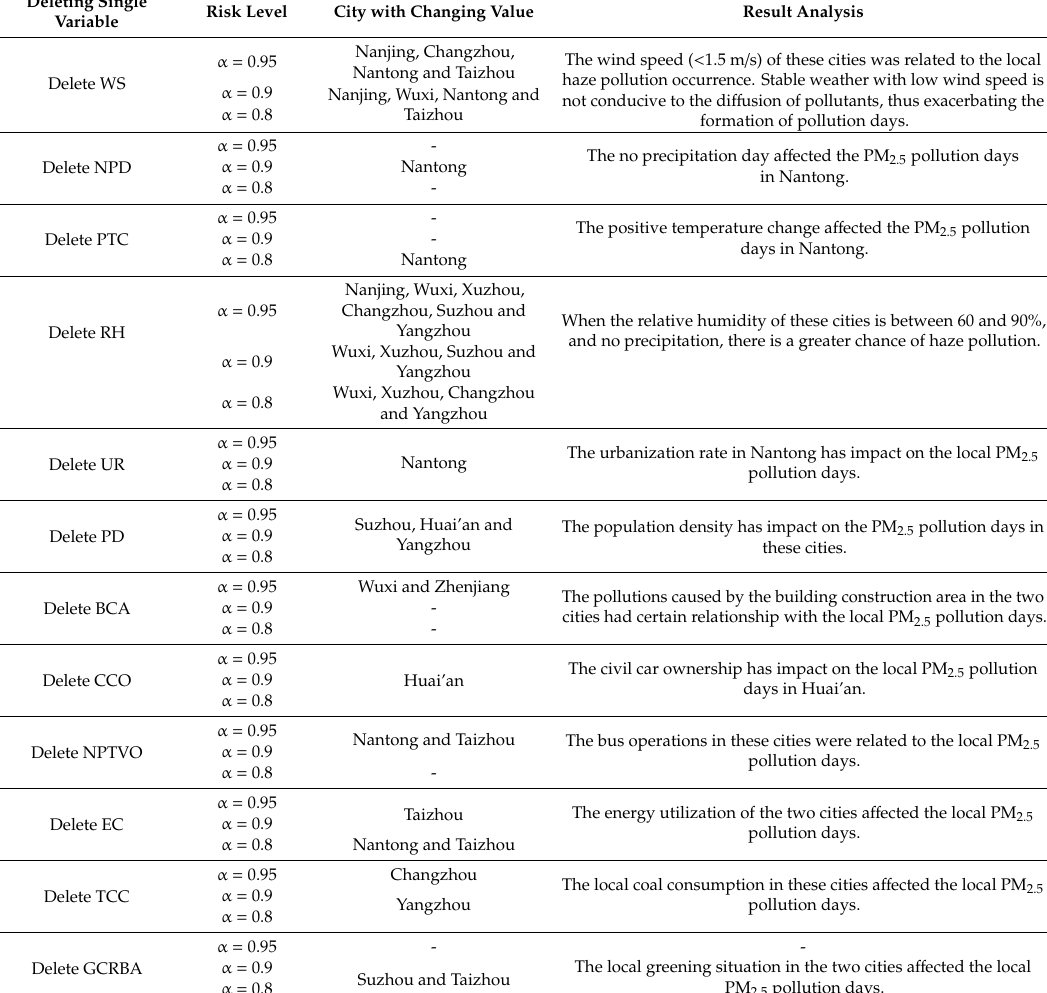
Table 5. The result analysis of deleting single input variables in